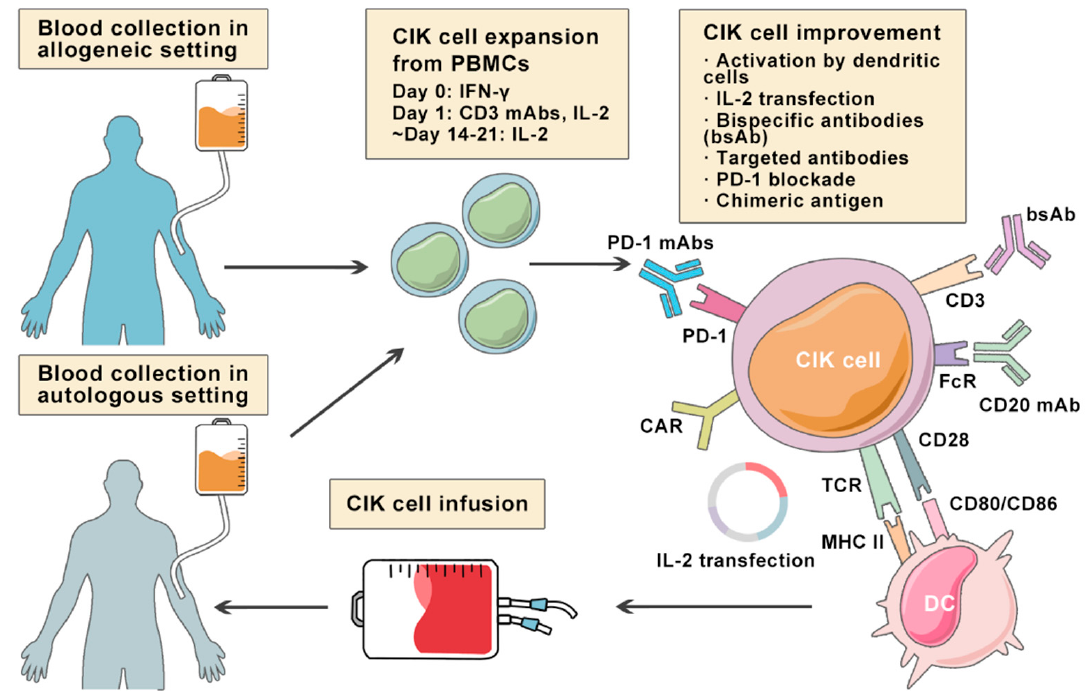
Figure 1. Overview of multiple approaches aiming at improving cytokine-induced killer (CIK)cell therapy in lymphoma. Illustration showing the expansion of autologous or allogeneic CIK cells from PBMCs collected from the blood of lymphoma patients under incubation of IFN- γ , CD3 mAbs, and IL-2 for 2–3 weeks. To increase the cytotoxicity and specificity of CIK cells against lymphoma cells, several modifications are implemented.